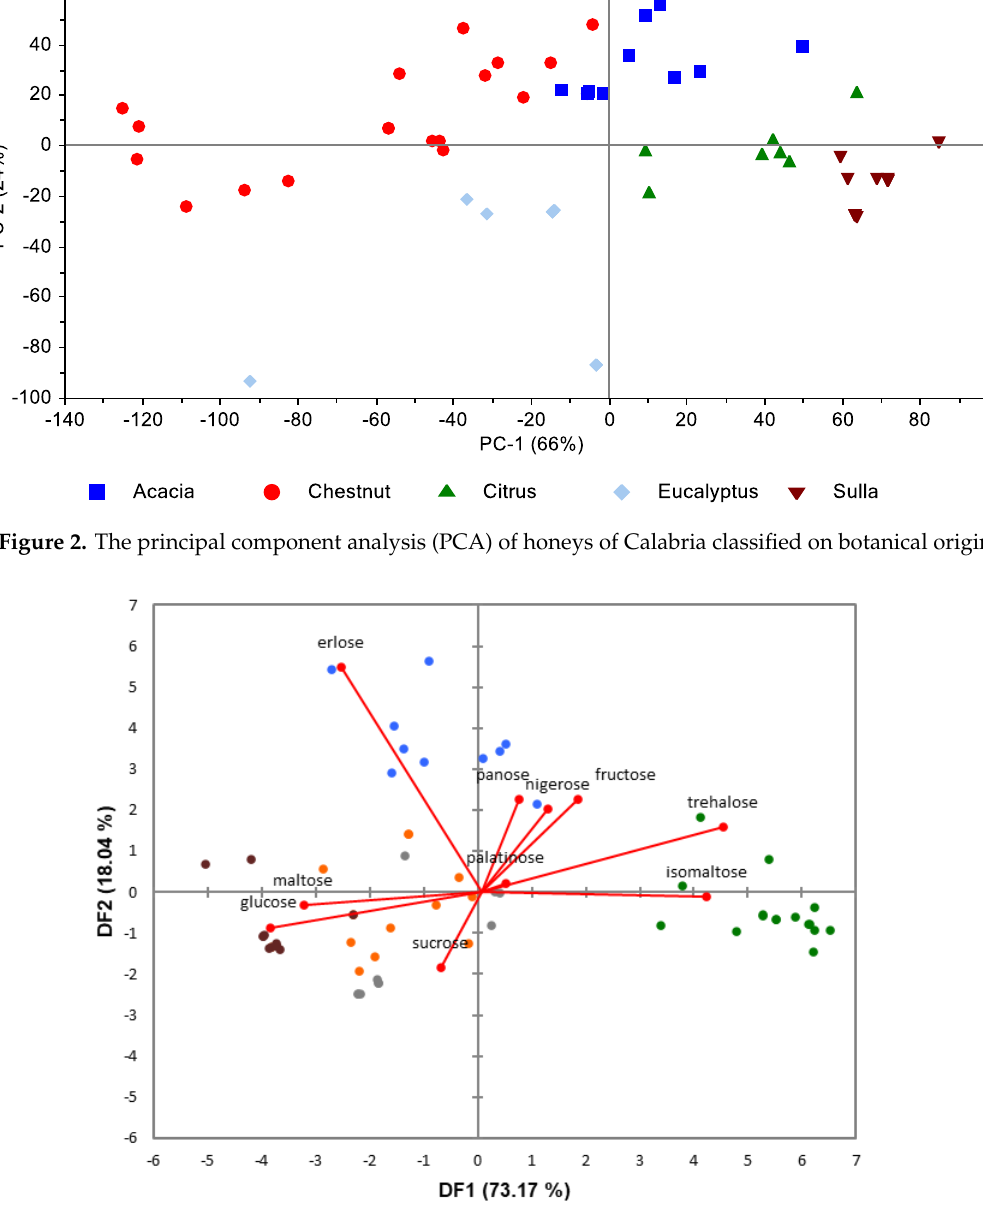
Figure 2. The principal component analysis (PCA) of honeys of Calabria classified on botanical origin.